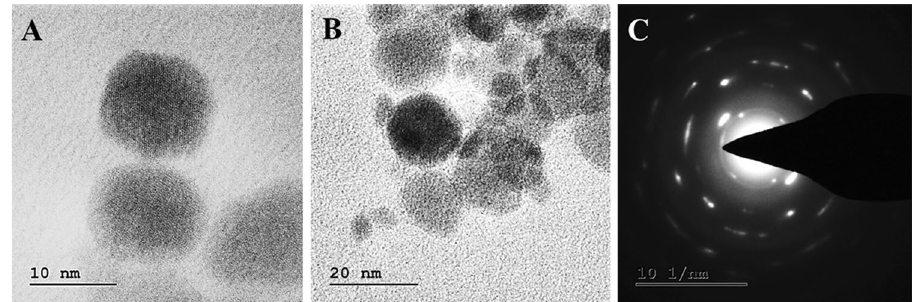
Figure 4. ( A , B ) Morphological characterization of Cu-NPs (C) SAED pattern of a single particle.